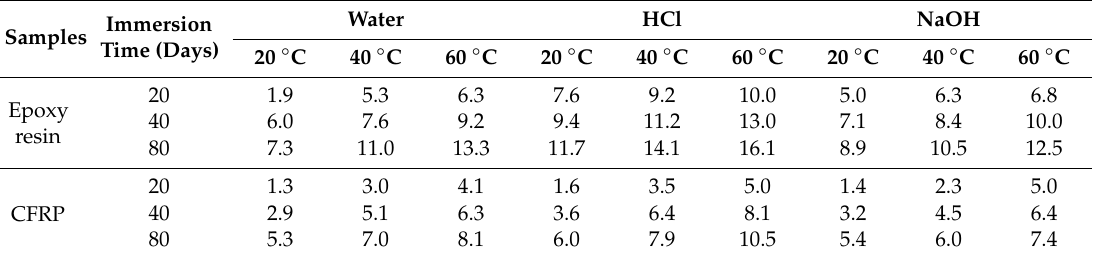
Tensile modulus reduction (%) of the epoxy and CFRP composites at di ff erent immersion